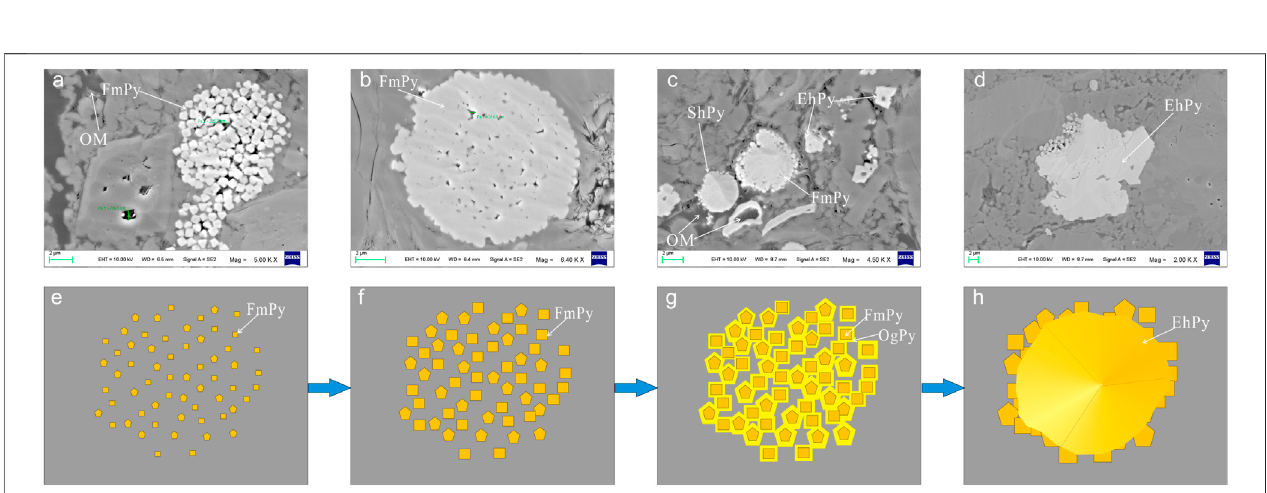
FIGURE 8 | Genetic model of framboidal pyrite in organic-poor shale. OM = organic matter; FmPy= framboidal pyrite; OgPy= pyrite overgrowth; EhPy= euhedral pyrite.